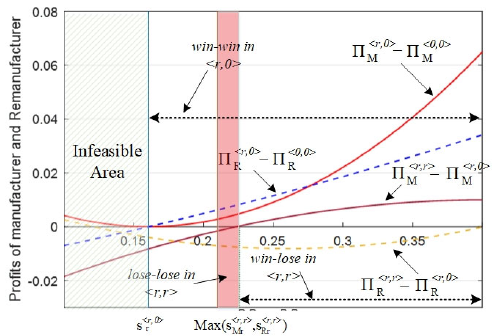
Figure 8. Comparison of profits between < r , 0 > and < r , r > scenarios.